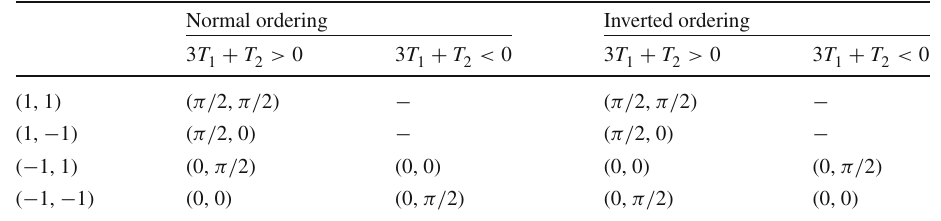
Table 3 In the TM2 μ - τ reflection symmetry scenario, + T > 0 and < 0, the for 3 T 1 2 predicted values of (ρ,σ) in the NO and IO cases with